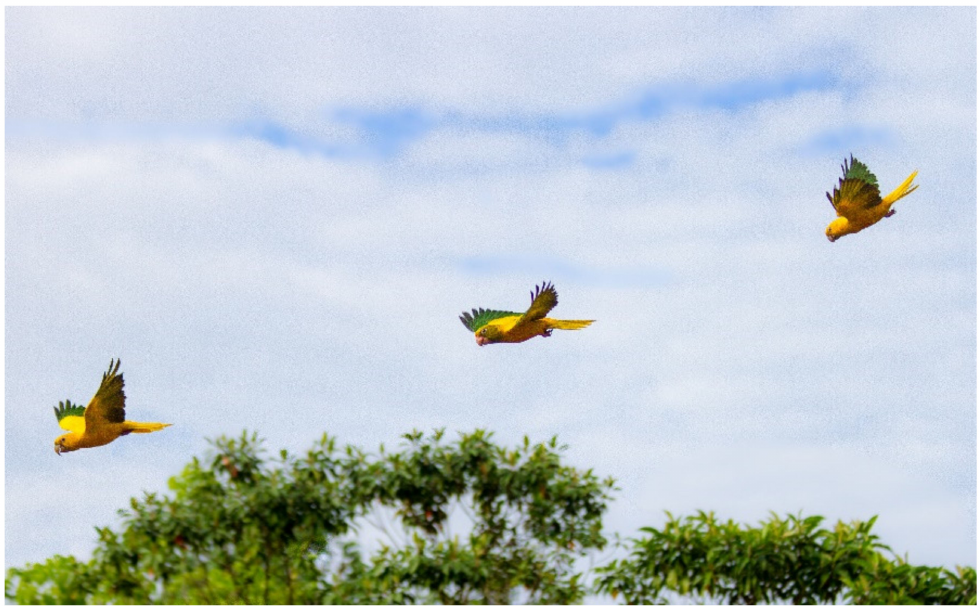
Figure 4. Released Golden Conure parents positioned in the extremities guiding the wild-born young at the center. Reintroductions often present pronounced mortality in the first month of release, and predation is often considered the main factor leading to loss of individuals [3]. In our study, after the release, one individual was predated but the main threat was electrocution in powerlines, which caused two deaths. Predation by boa snakes, Boa constrictor ,